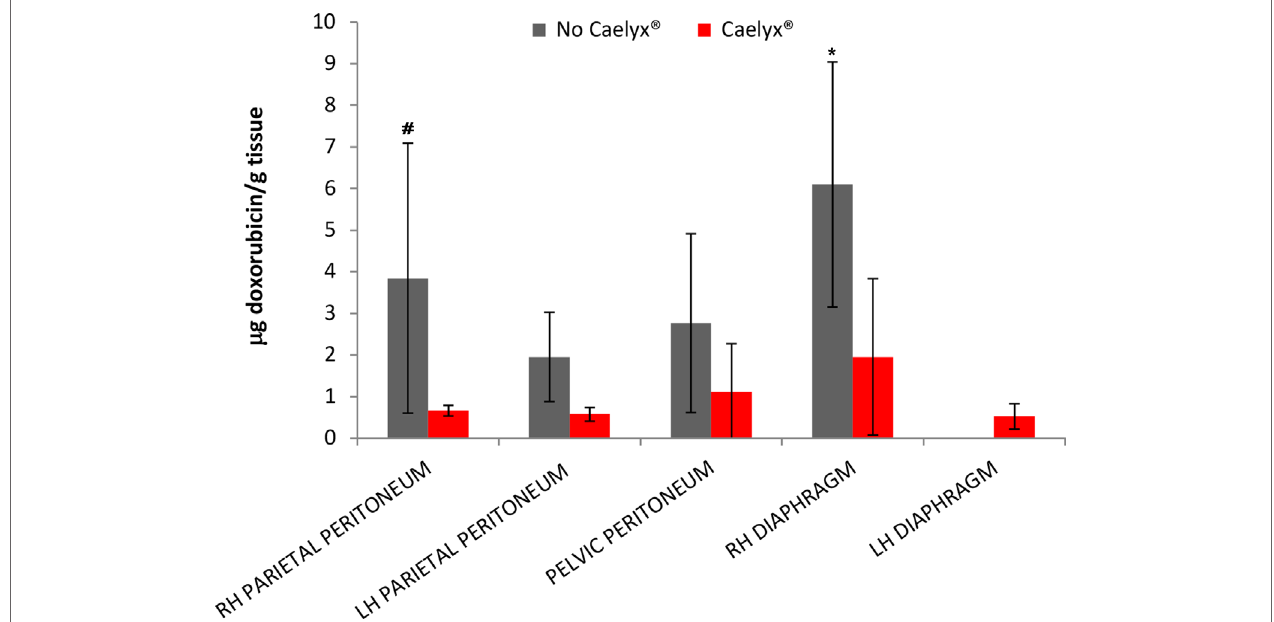
FIGURE 1 | Amount of doxorubicin and pegylated liposomal doxorubicin in the different tissues (µg drug/g tissue). Results are expressed as mean ± SD. # p < 0.05 vs. pegylated liposomal doxorubicin, *p < 0.01 vs. pegylated liposomal doxorubicin, by two-way ANOVA followed by Bonferroni post